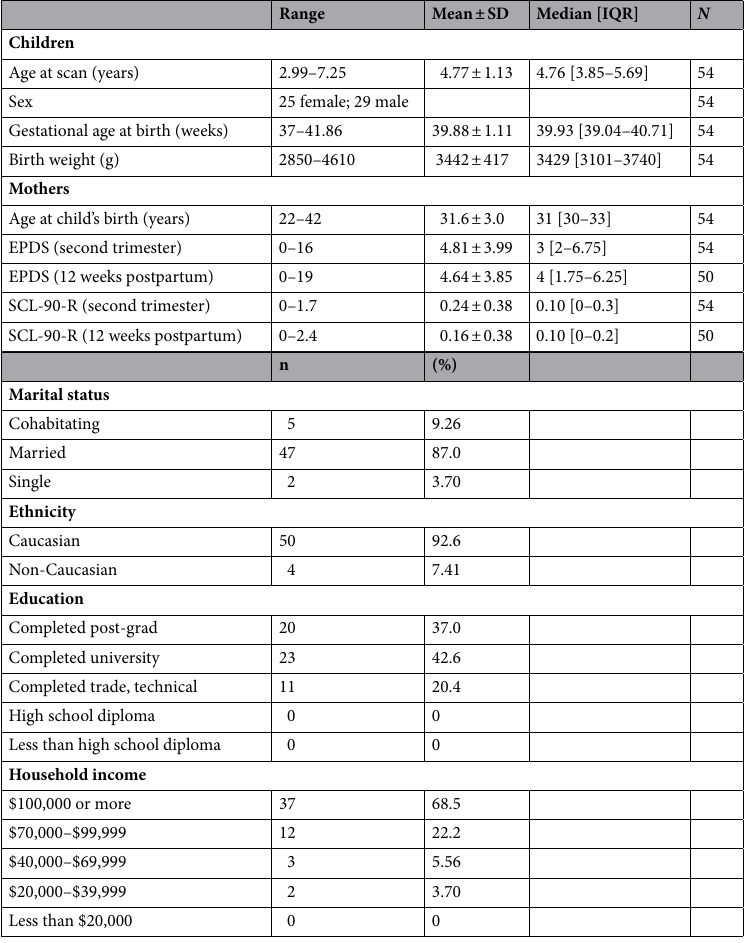
Table 1. Descriptive information of participants. EPDS, Edinburgh Postnatal Depression Scale; SCL-90-R, Symptom Checklist-90-Revised.